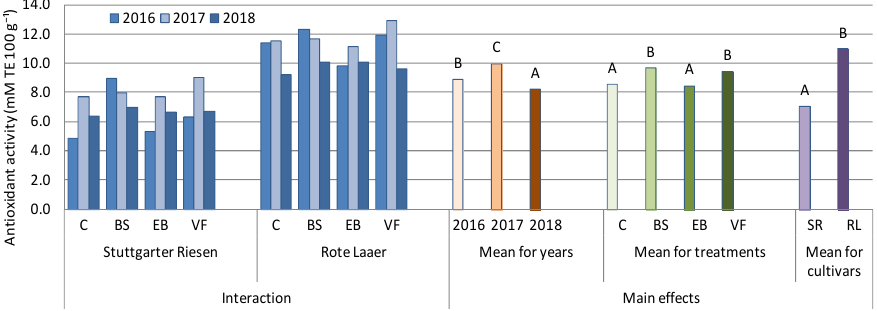
Figure 4. Antioxidant activity in onion bulbs depending on the cultivar, treatments, and years of investigation. The data give the mean values of four replications. Different letters denote significant differences: lowercase letters refer to the interaction and capital letters to the main effects (Fisher’s test, p ≤ 0.05). Abbreviations: C—control; BS—B-Stimul; EB—EkoBooster 2; VF—VermiFit A; SR—Stuttgarter Riesen; RL—Rote Laaer.